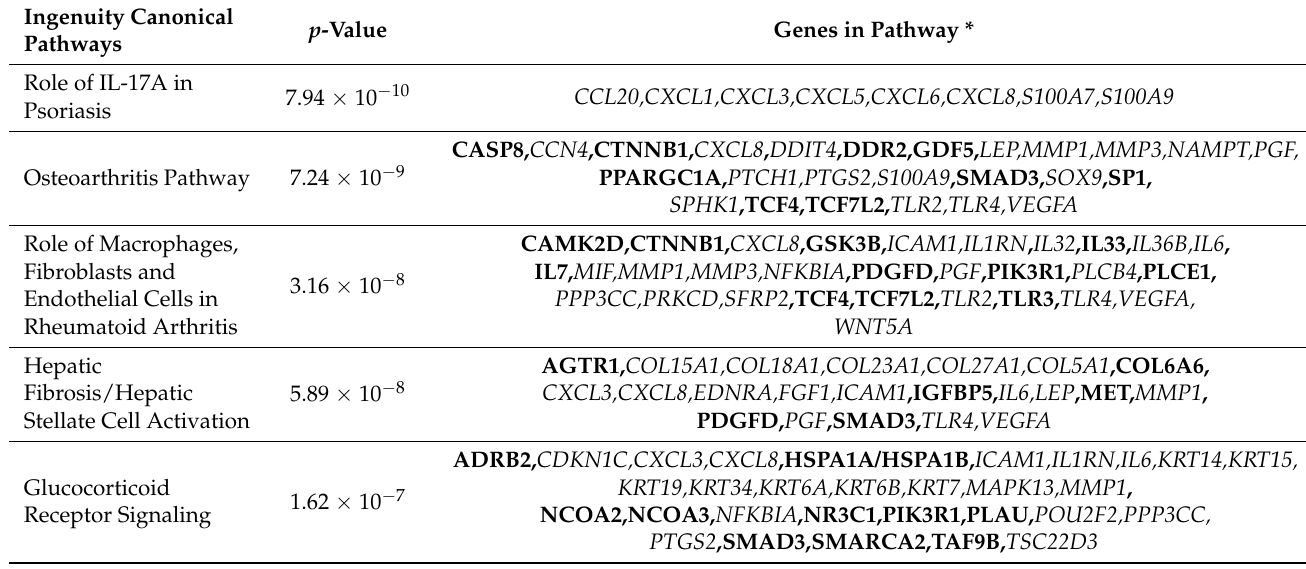
Table 5. Top five canonical pathways identified by IPA in skin fibroblasts and the differentially-regulated genes associated with these pathways.